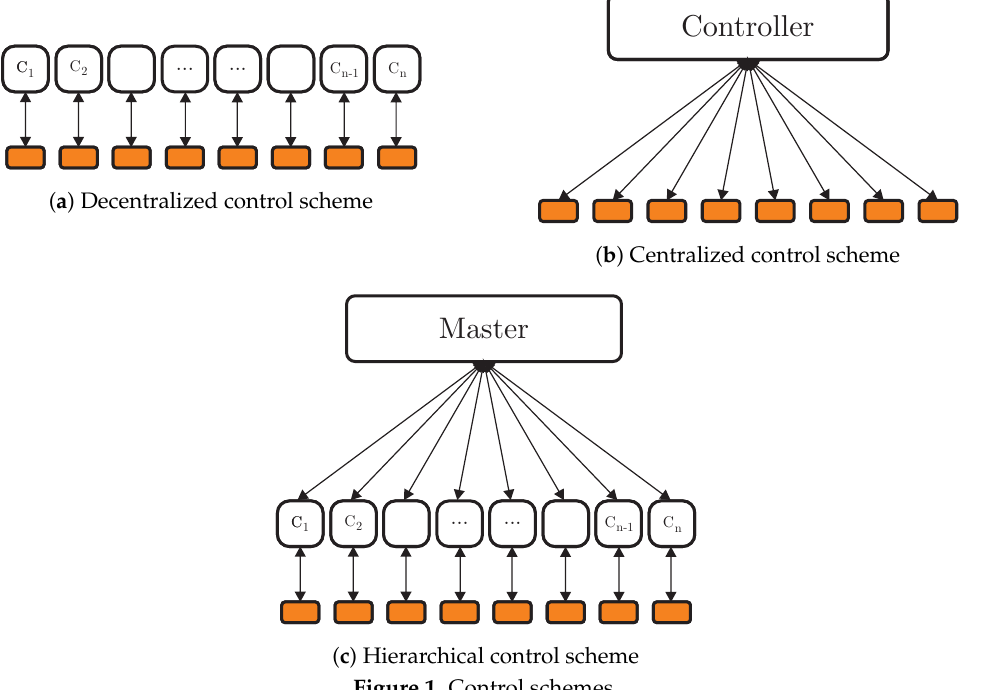
Figure 1. Control